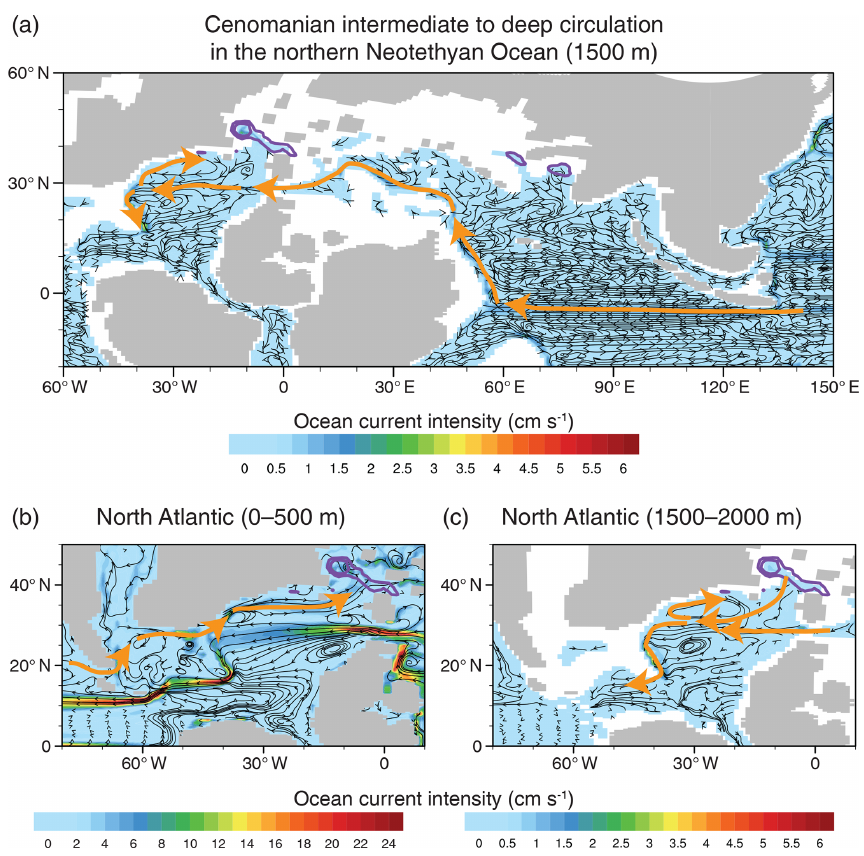
Figure 14. Cenomanian ocean circulation in (a) the northern Neotethyan Ocean at 1500m depth, (b) the North Atlantic Ocean between 0 and 500m depth, and (c) the North Atlantic Ocean between 1500 and 2000m depth. Orange contours represent major pathways of water masses. Purple contours are the maximum winter MLD (500m